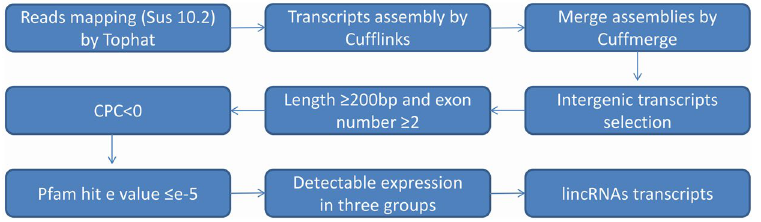
Figure 1. Overview of the identification pipeline for lincRNAs in this study. See the main content for details.